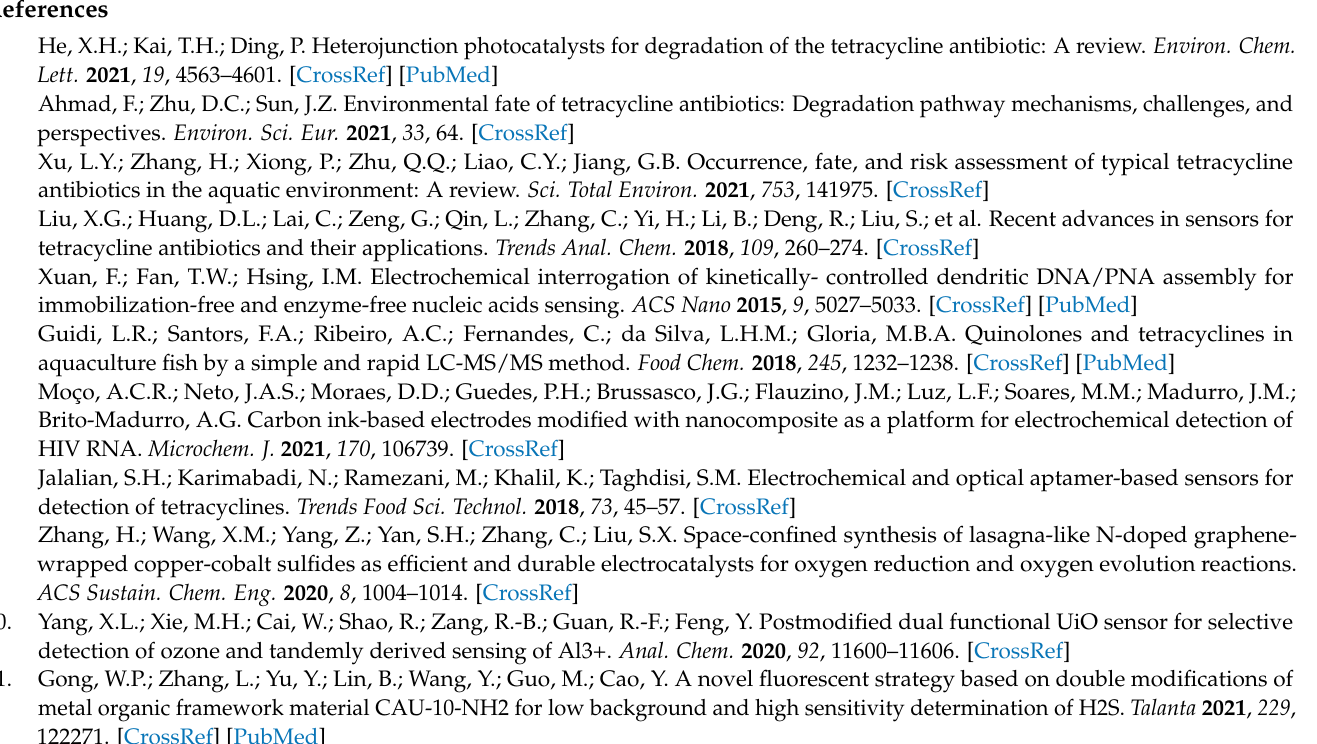
( B~D ) elemental mappings of the prepared CuS/ZnS. Figure S2: ( A , C ) Steady-state kinetic assays of CuS/ZnS catalytic performance for different concentrations of H 2 O 2 with 0.2 mM TMB, ( B , D ) that for different concentrations of TMB with 20 mM H 2 O 2 . Figure S3: Electrochemical impedance spec- troscopy ( A ), photoluminescence spectra ( B ) and photocurrent spectra ( C ) of ZnS and CuS/ZnS composites with different mass ratio of CuS. Figure S4: The effect of catalyst loading amounts ( A ), TMB concentrations ( B ), pH values ( C ) and reaction temperatures ( D ) on the TC detection. Table S1: The comparison of the linear range and LOD of this strategy and other reported method for TC determination. Figure S5: ( A ) The degradation rate of the optimized CuS/ZnS to TC, ( B ) the apparent rate constant (K) plot of the degradation. Figure S6: ( A ) UV-Vis DRS graph of CuS and ZnS, ( B ) UV-Vis DRS graph of CuS/ZnS nanocomposite with different amount of CuS. Figure S7: The SEM images of the optimized CuS/ZnS before ( A , B ) and after ( C , D ) reuse. References [33–36] are cited in the supplementary